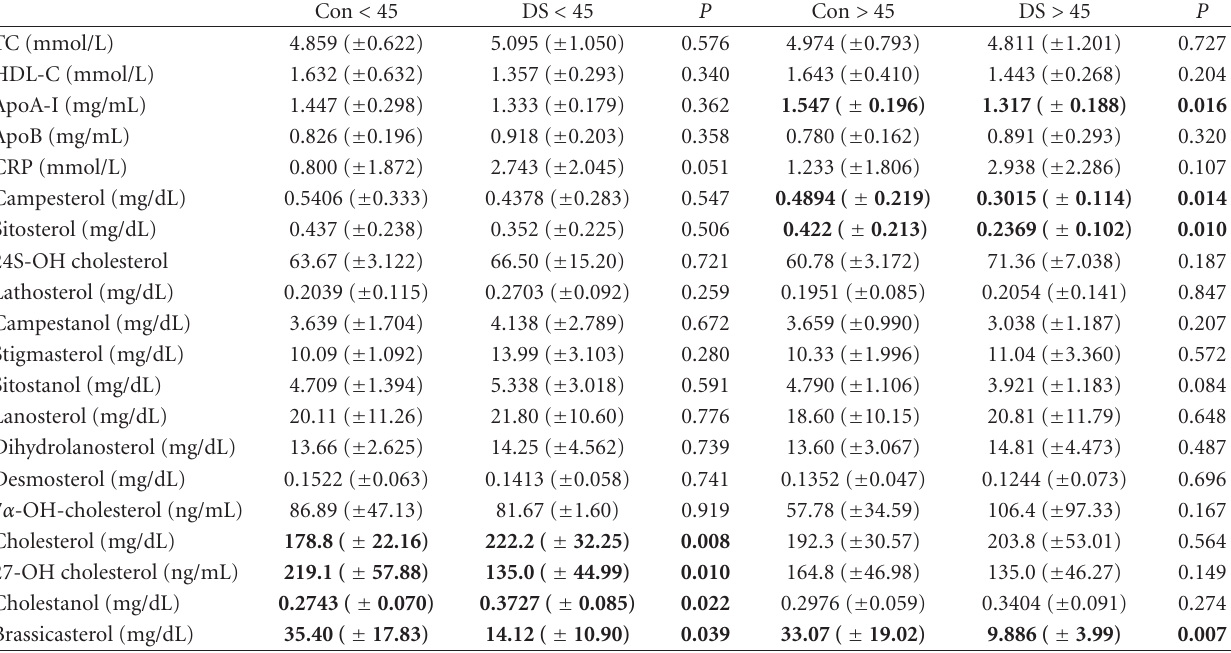
Table 3: Serum analytes in control and DS cohorts by age. Analytes shown in bold are significantly di ff erent between control and DS groups by unpaired student’s t -test. Welch’s correction was applied when variances were significantly di ff erent between